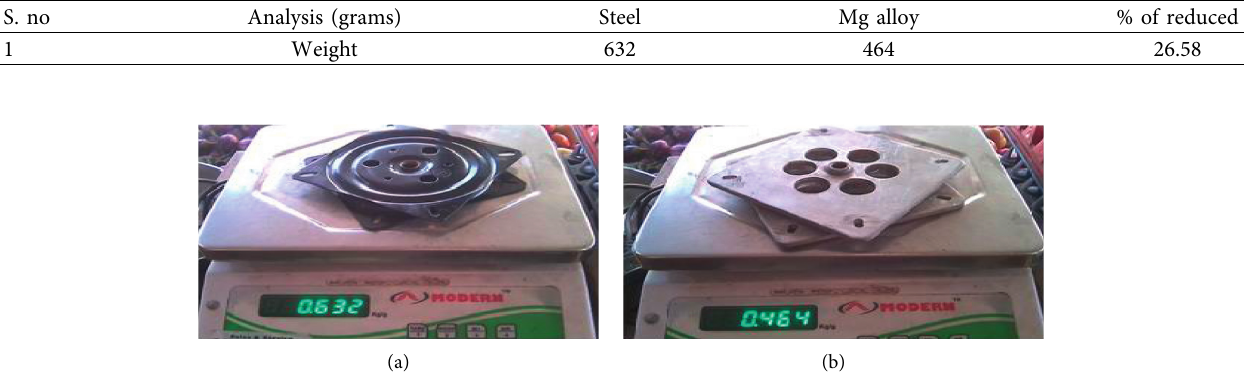
Table 14: Weight for both the